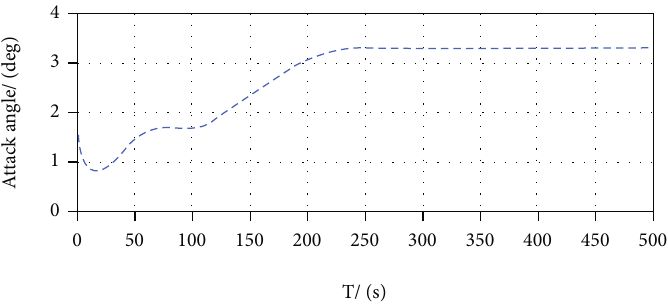
Figure 7: Angle of attack.